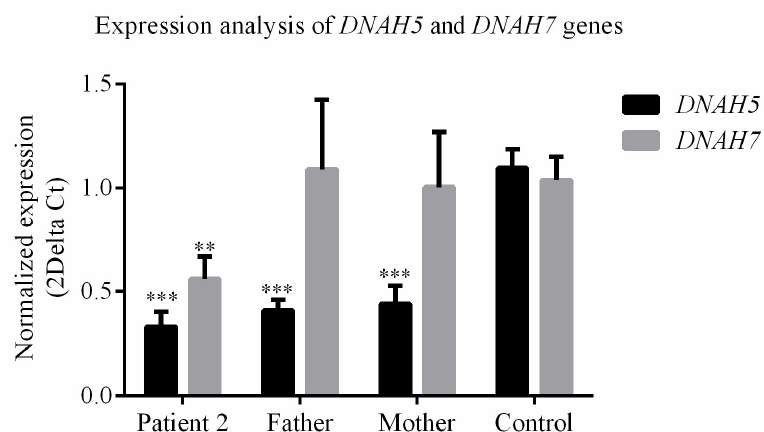
Figure 4. RT-PCR analysis of DNAH5 and DNAH7 mRNA expression levels in epithelial respiratory cells from Patient-2 and his parents, compared to healthy donors (a fluorescent dye used: SYBR Green). ECM7 was used as the reference gene. Statistical significance determined using the Mann–Whitney test, with alpha < 0.05. ** = p value < 0.01; *** = p value < 0.001.